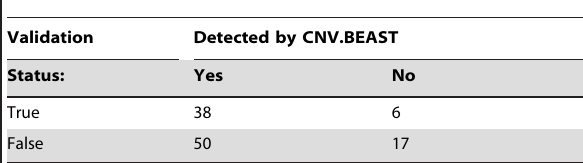
Table 2. CNV.BEAST calls and Validation Status.